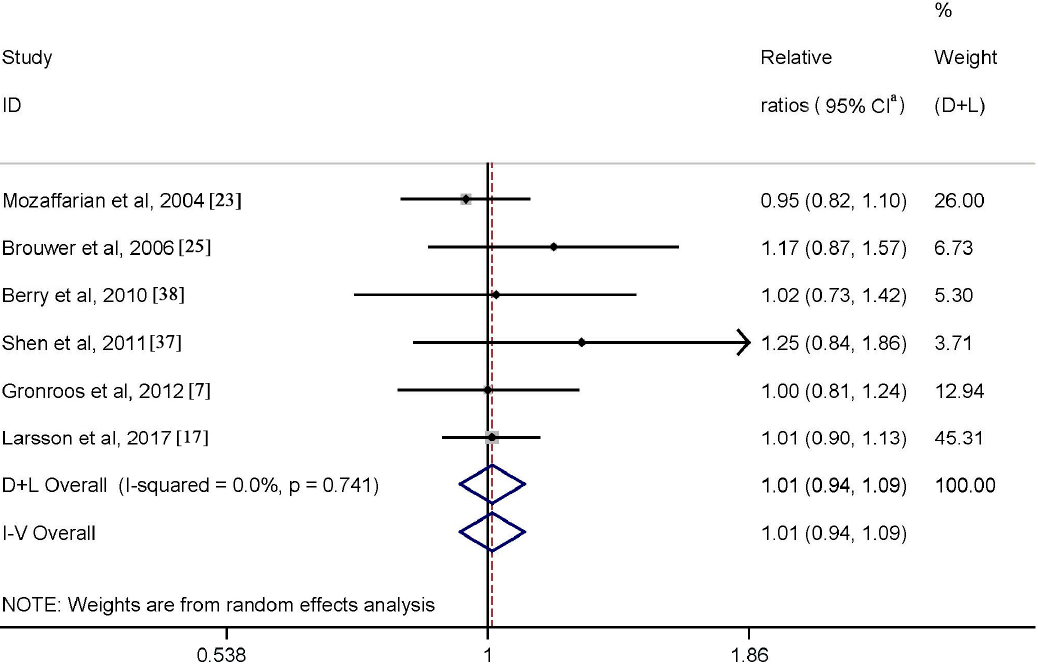
Figure 2. Meta-analysis of fish consumption and AF risk (highest vs. lowest). a CI: confidence intervals.